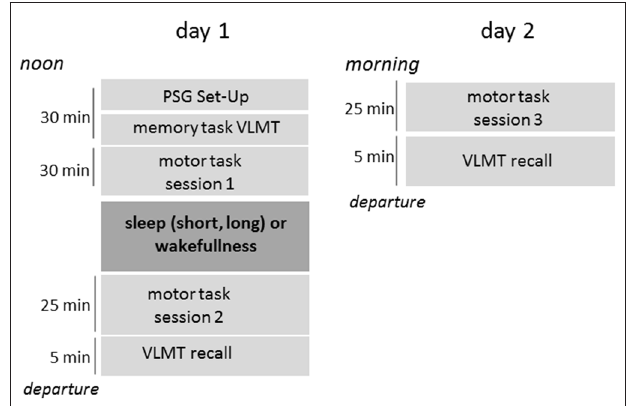
FIGURE 1 | Timeline of the study design. PSG, Polysomnography; VLMT, Verbal Learning and Memory Task